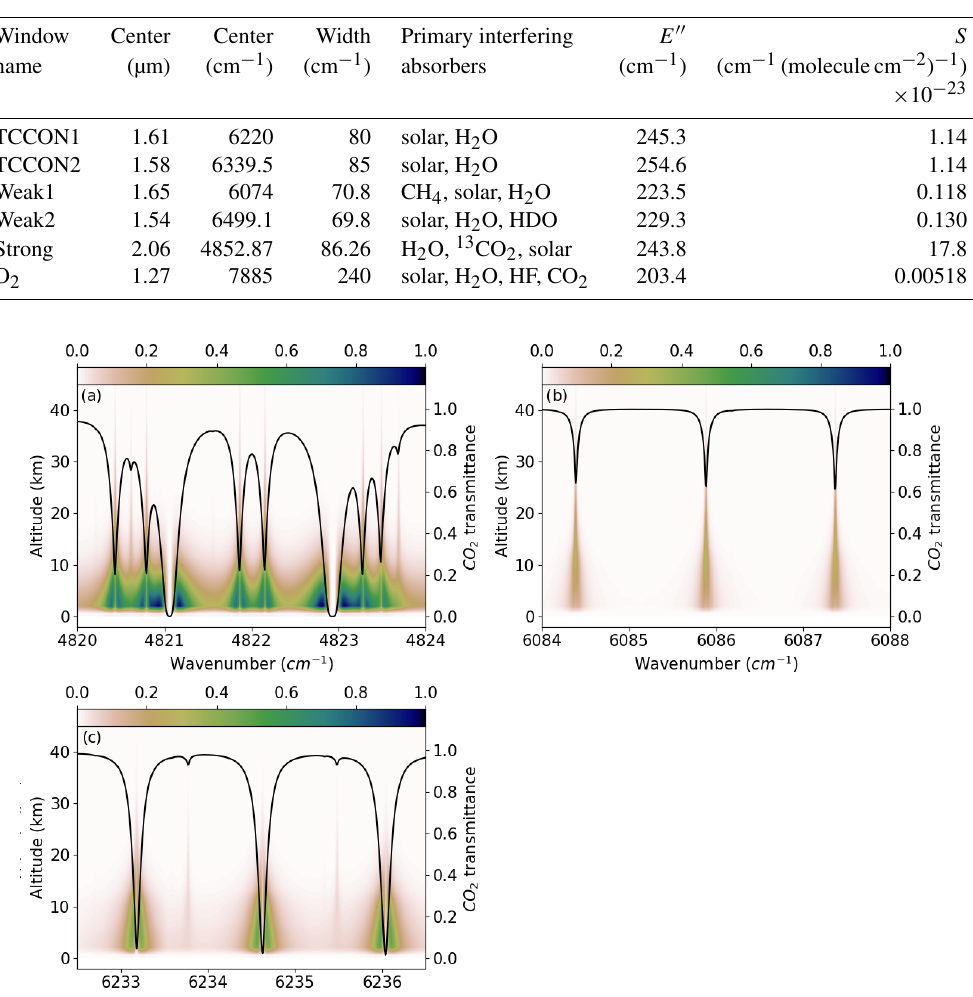
Table 1. CO 2 spectral windows used with GFIT2. Interfering absorbers labeled “solar” are due to absorption by heavy metal ions (e.g., Fe, Si, Ca, Ni) in the solar photosphere. Also shown are the strength-weighted averages of the lower-state energy ( E (cid:48)(cid:48) ) and of the line strengths ( S ) over all the CO 2 lines in each window. The column of O 2 , retrieved with scaling retrievals from the O 2 window, is used to compute XCO 2 .